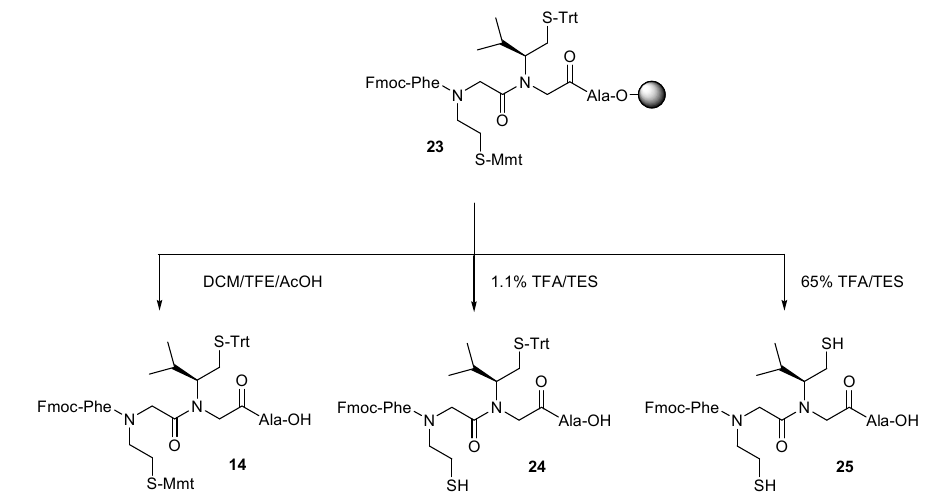
Figure 4. LC-MS analysis of the oxidation of crude hybrid 21 in DMSO, after 12 h ( A ) and 48 h ( B ). Column: Nucleosil C8, 7 μm, 125  4 mm; flow rate: 1 mL/min; gradient: from 50 to 100% acetonitrile